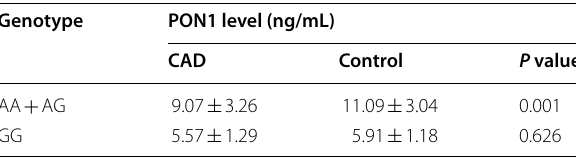
All values are expressed as mean